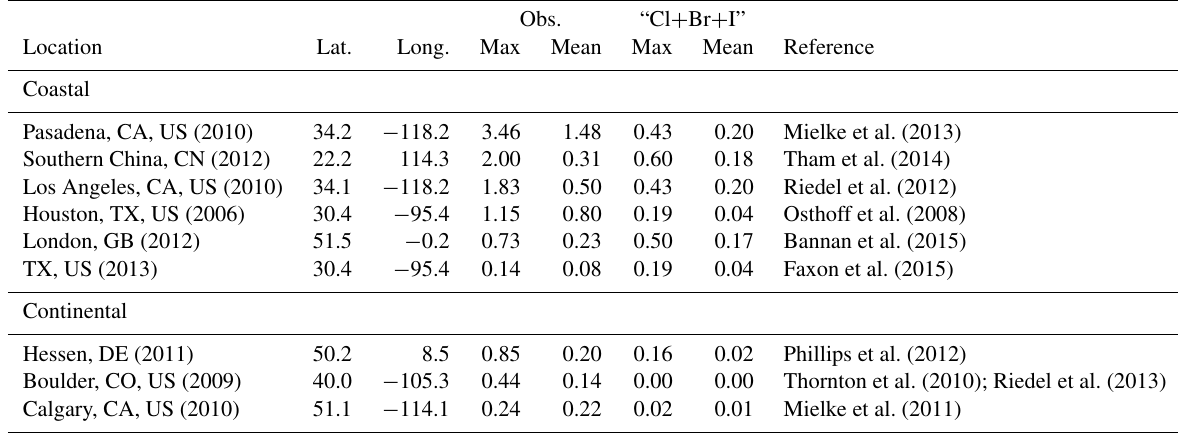
Table 3. Comparison between modelled and observed ClNO 2 . Concentrations are shown as the maximum and average of the daily maximum value for the observational and equivalent model time period. The model values are taken for the nearest time step and location within the analysis year (2005). Obs. “Cl + Br + I” Location Lat. Long. Max Mean Max